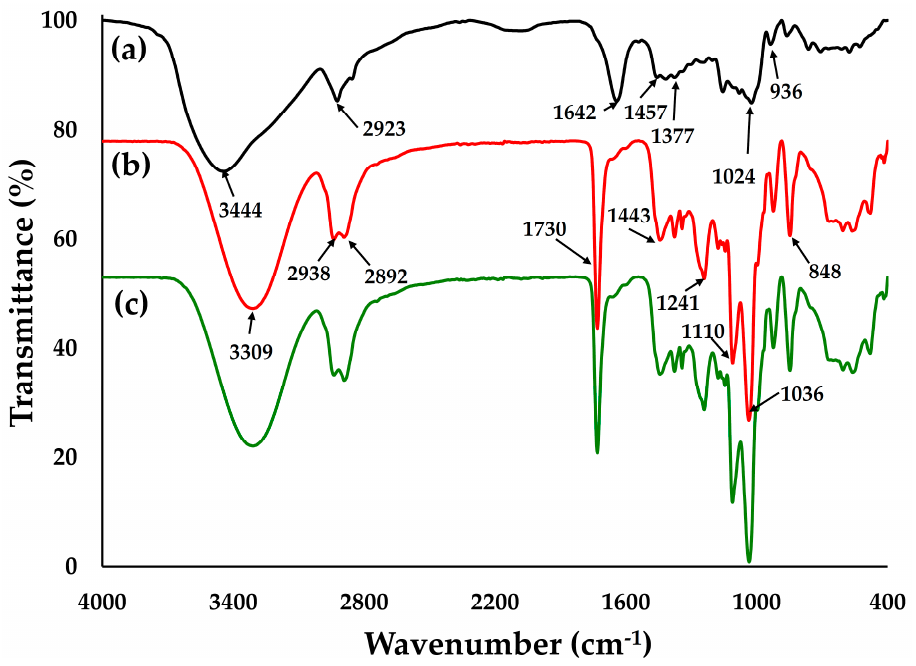
Figure 9. FTIR spectra of ( a ) silver-nanoparticle-complexed G. applanatum , ( b ) blank film, and ( c ) topical film containing silver-nanoparticle-complexed G. applanatum . DSC Table 3. Identification of the main peaks from reported FTIR